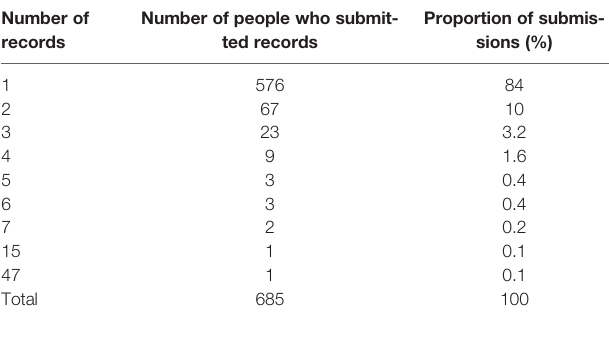
TABLE 2 | Number of ladybird records, no of people who submitted records and proportions of submissions (n = 685). Number of Number of people who submit- Proportion of submis- records ted records sions